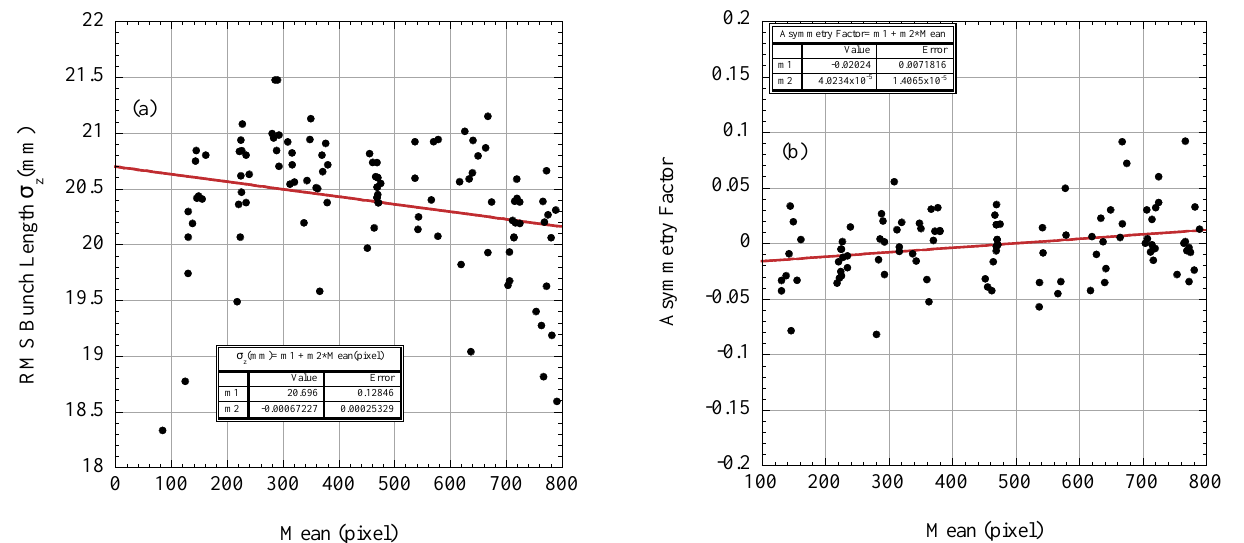
FIG. 9. (Color) (a) The bunch length and (b) asymmetry factor as a function of trigger setting using the synchroscan calibration curve shown in Fig.